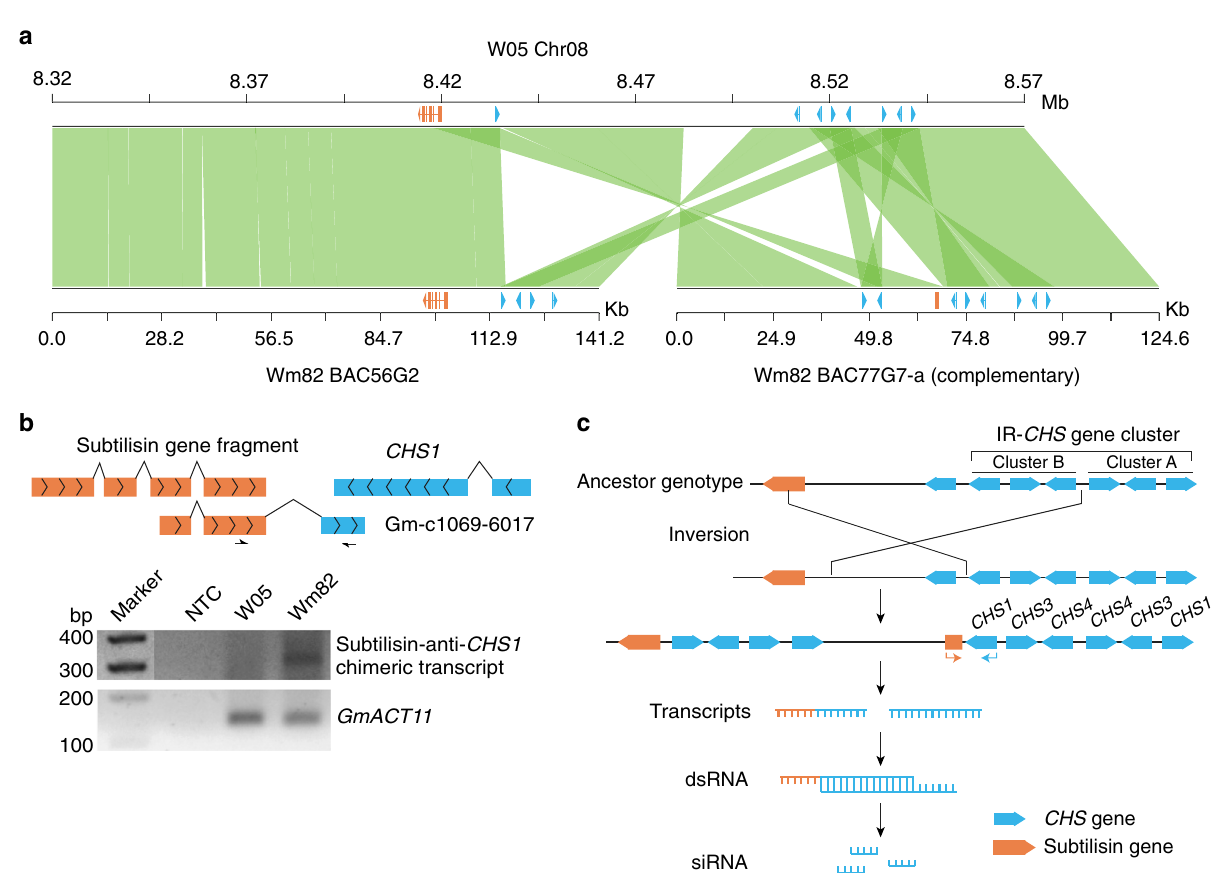
Fig. 2 Causal structural variation that controls soybean seed coat pigmentation. a Sequence comparison between W05 genome and Wm82 bacterial arti fi cial chromosome (BAC) sequences at the I locus region. CHS genes and subtilisin gene/gene fragments are indicated with blue and orange, respectively. b Top panel: cartoon shows the exon structure of the subtilisin gene fragment (orange), the CHS1 gene (blue), and the Expressed Sequence Tag (EST) sequence Gm-c1069 – 6017. Positions of primers designed for PCR ampli fi cation of subtilisin-anti- CHS1 chimeric transcript are indicated with black arrows. Bottom panel: PCR ampli fi cation of the subtilisin-anti- CHS1 chimeric transcript. Experiment was repeated at least twice with independent samples. Marker: 1 Kb Plus DNA ladder (NEB, cat. N3200S). NTC, no template control. GmACT11 is used as a housekeeping control. Unprocessed gel image is provided in Source Data fi le. c Proposed model for the generation of siRNAs originated from a large structural rearrangement in the I locus. CHS genes and the subtilisin gene/gene fragments are illustrated as blue and orange, respectively. Arrowheads indicated the direction of transcription that causes the formation of double-stranded RNA. Cluster A and B are named according to a previous report 23 . IR-CHS gene cluster: inverted repeat of CHS gene